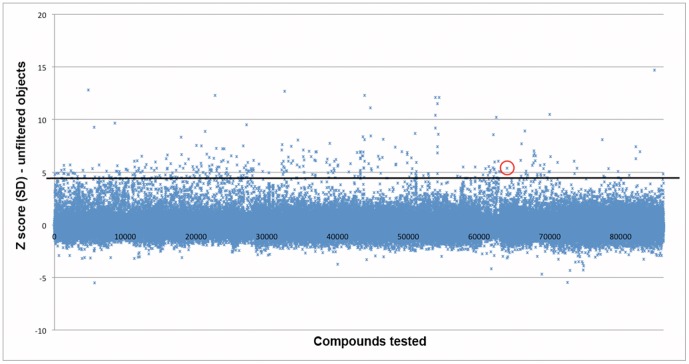
A Calcein based high throughput screen identifies potential regulators of hESC survival.Each blue point represents one of the 85586 small molecules tested. The black bar represents the cutoff (Z score ≥4.58) used to select a set of 320 compounds for follow up testing. The ROCK inhibitor HA-1077 is circled in red (Z score: 5.34).